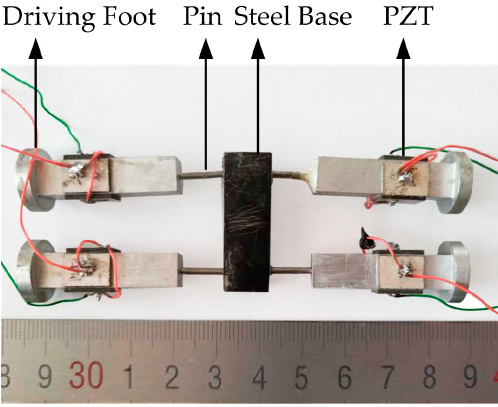
Figure 5. Prototype of the proposed robot.